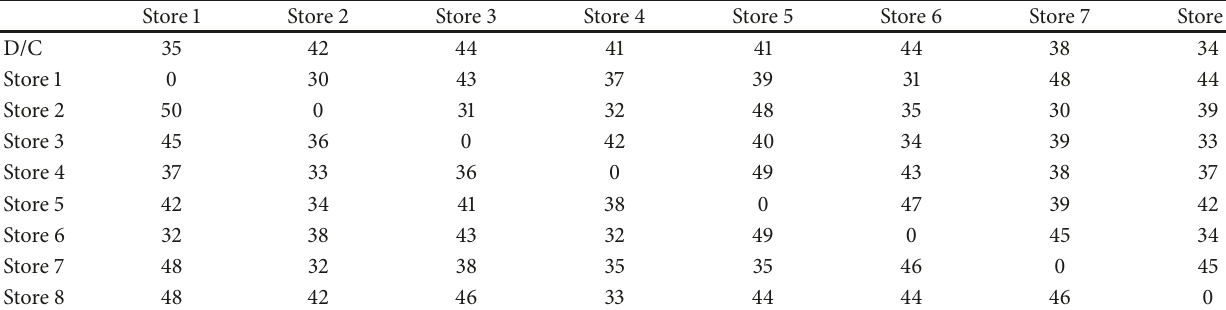
Table 4: Shipping costs for the node pairs (CNY).